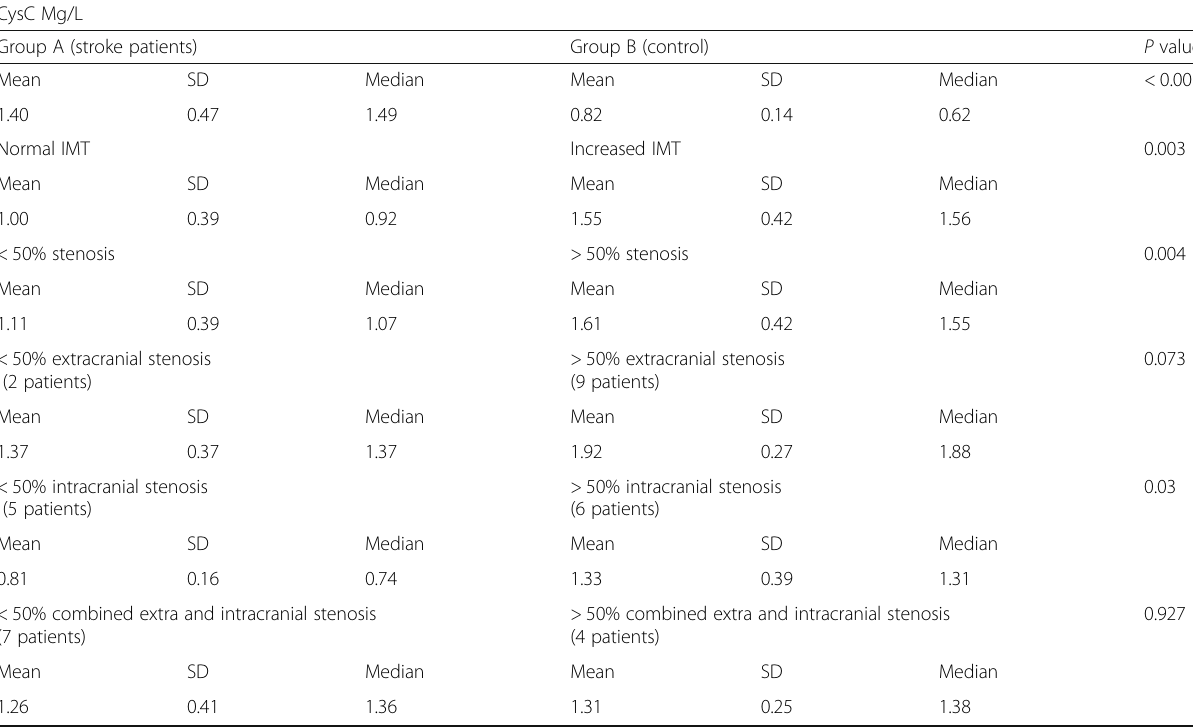
Table 1 Level of CysC according to groups, IMT, site, and degree of stenosis CysC